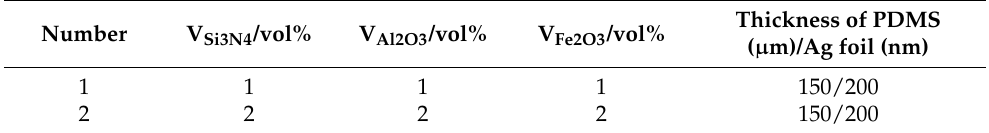
Table 3. The design of mixing particles in proportion.